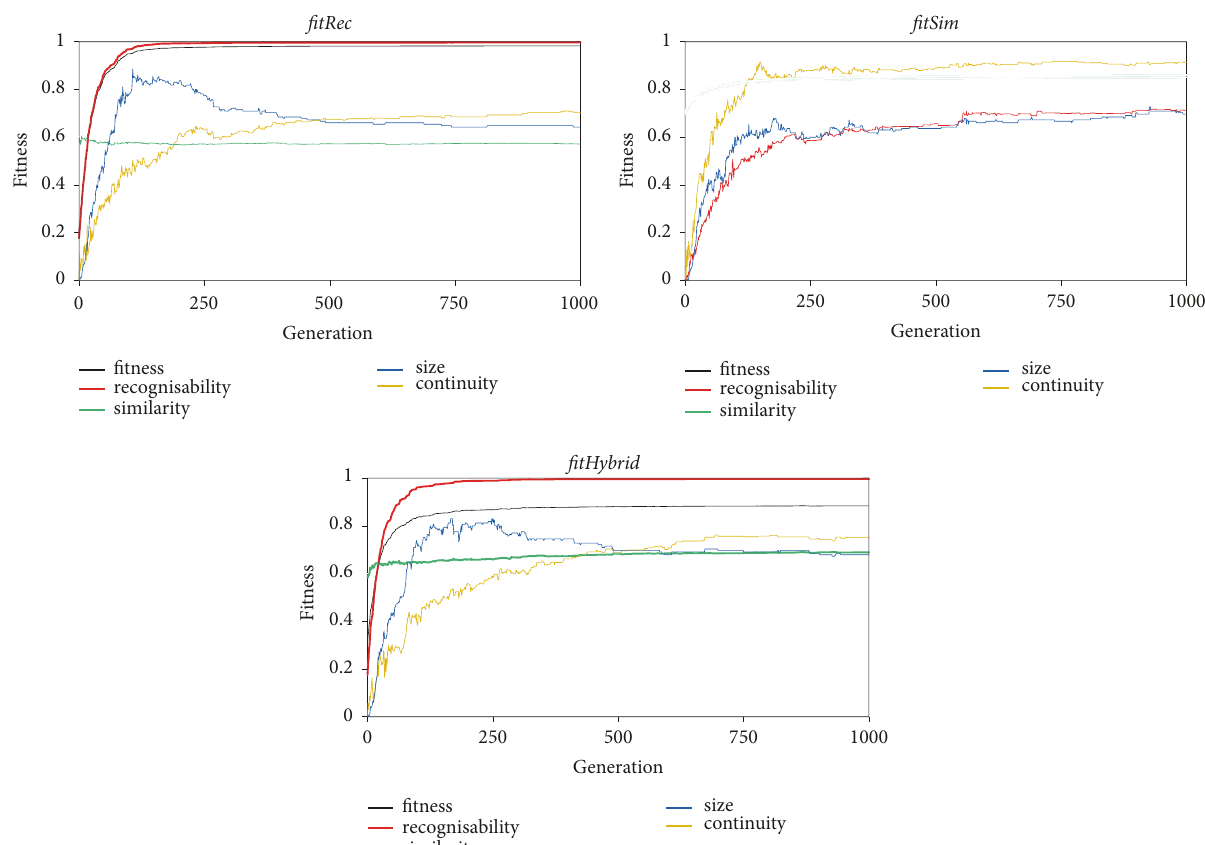
Figure 8: Progression of the fitness and features’ values of the fittest stencil when fitness functions fitRec (top left plot), fitSim (top right plot), and fitHybrid (bottom plot) guide the evolutionary process. The visualised results are the average of 30